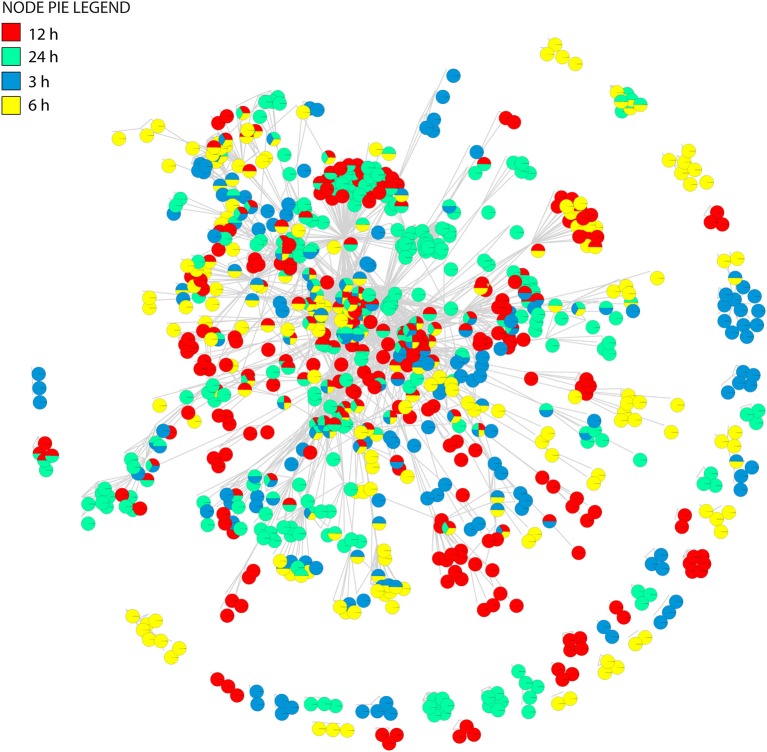
The union of tripartite networks. The pie-node representation enables to identify presence/absence of individual nodes across four time dependent networks.